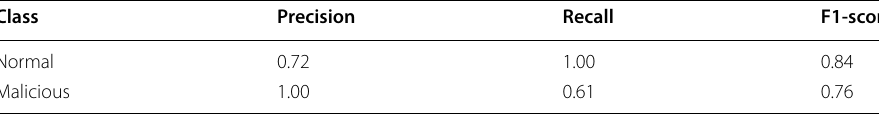
Table 17 Classification report of SVM